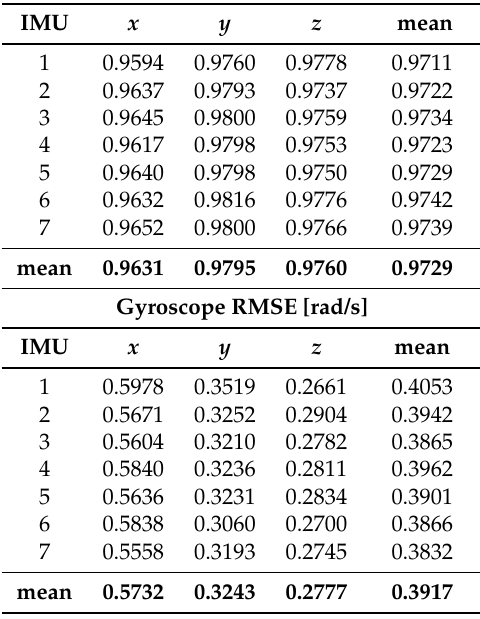
Table A4. Pearson correlation coefficients and root mean squared errors (RMSE) between real and re-simulated accelerometer data from a capturing setup where IMUs were mounted on a person during walking and were additionally tracked with a marker based optical